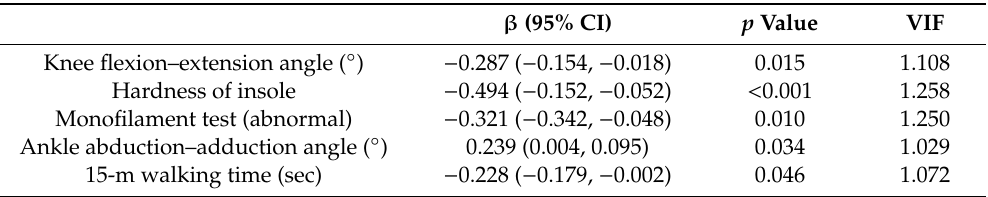
Table 2. Relationship between the SPR-i (Shear stress Pressure Ratio of time integral value), lower extremity joint angles, and characteristics in the first metatarsal head.